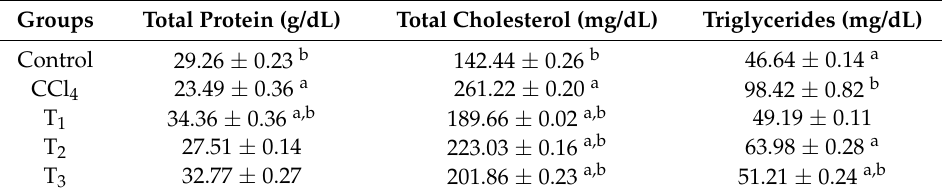
Table 3. Effect of Piper guineense on serum total protein, total cholesterol, and triglyceride levels.